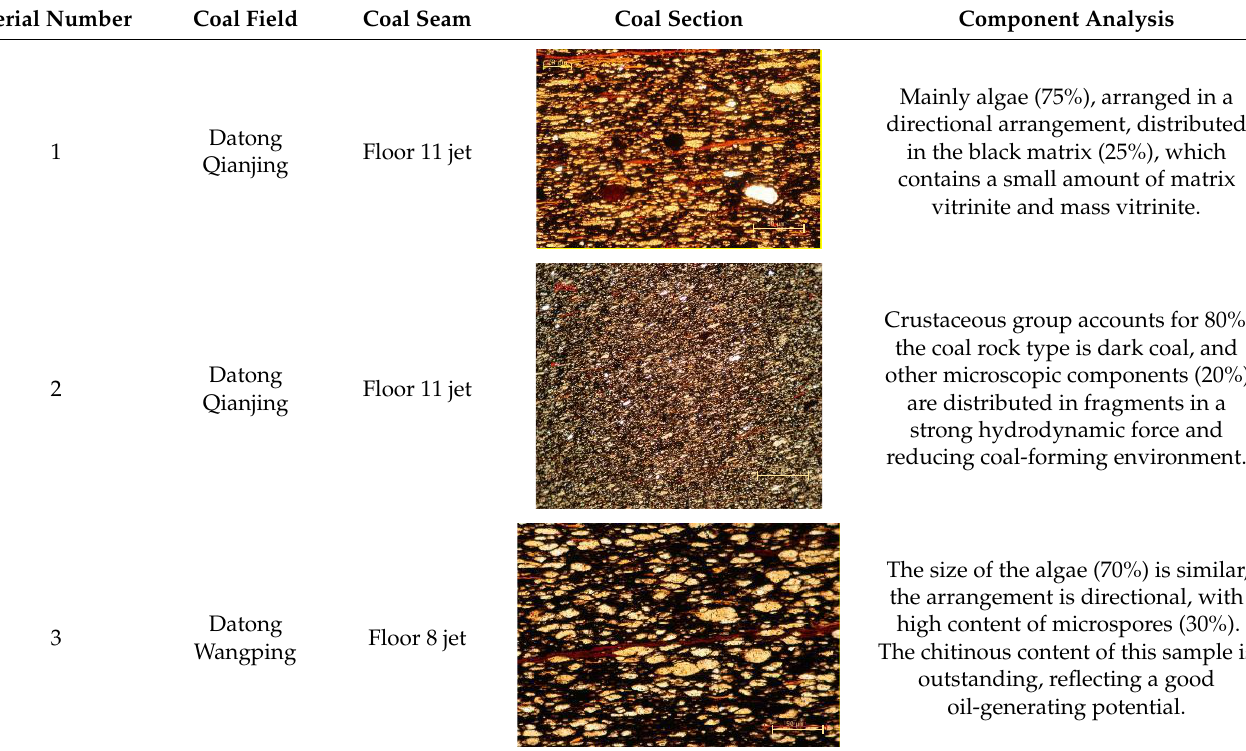
Table 3. Microscopic observation characteristics of jet slices from different layers in the Datong Coalfield and Fushun Open-pit Mine.